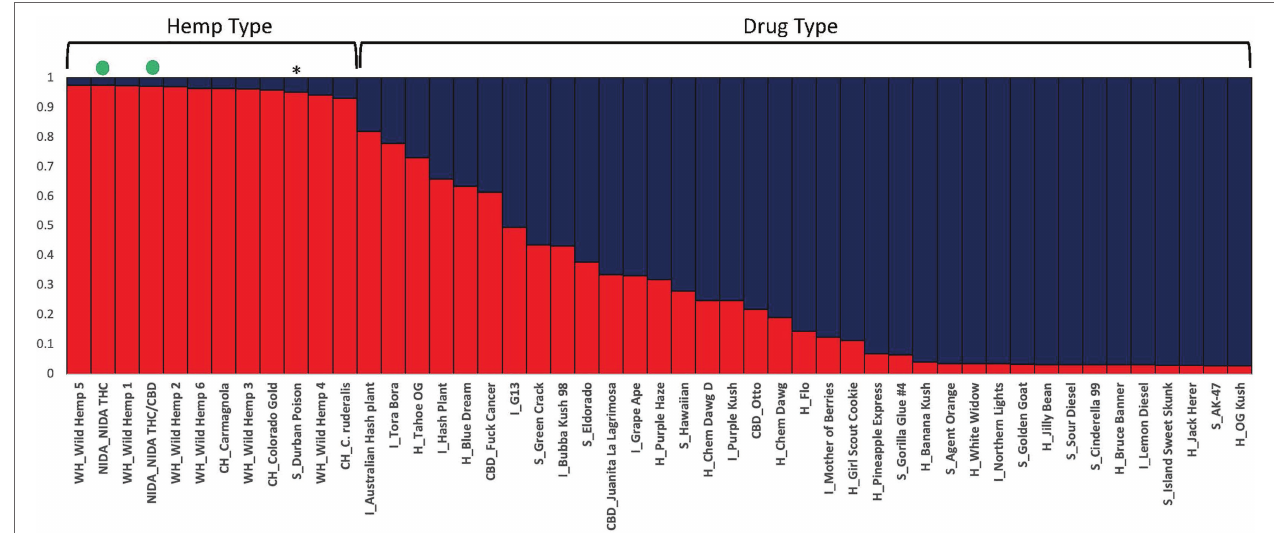
FIGURE 3 | Bayesian clustering analysis from STRUCTURE with the proportion of inferred ancestry for two genetic groups (K = 2) sorted by proportion of genotype assignment. Each individual is represented as a single bar in the graph. The NIDA samples are indicated by a green dot. * “Durban Poison” is a drug type assigned 0.95 to hemp ancestry. The letters preceding the sample name relate to the category the sample was place in (WH, wild hemp; CH, cultivated hemp; CBD, high CBD drug type; S, sativa drug type; H, hybrid drug type; I, Indica drug